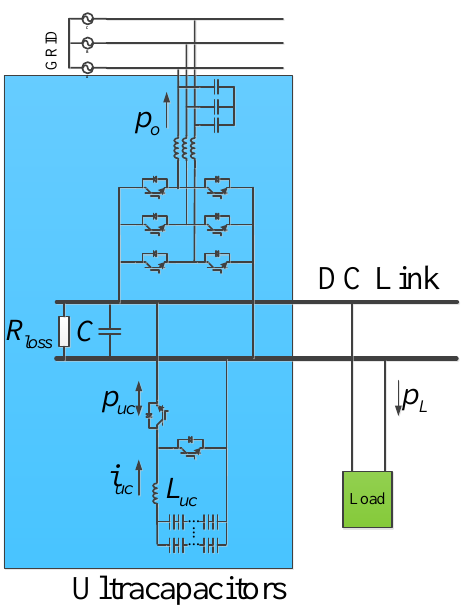
Figure 1. Diagram of system